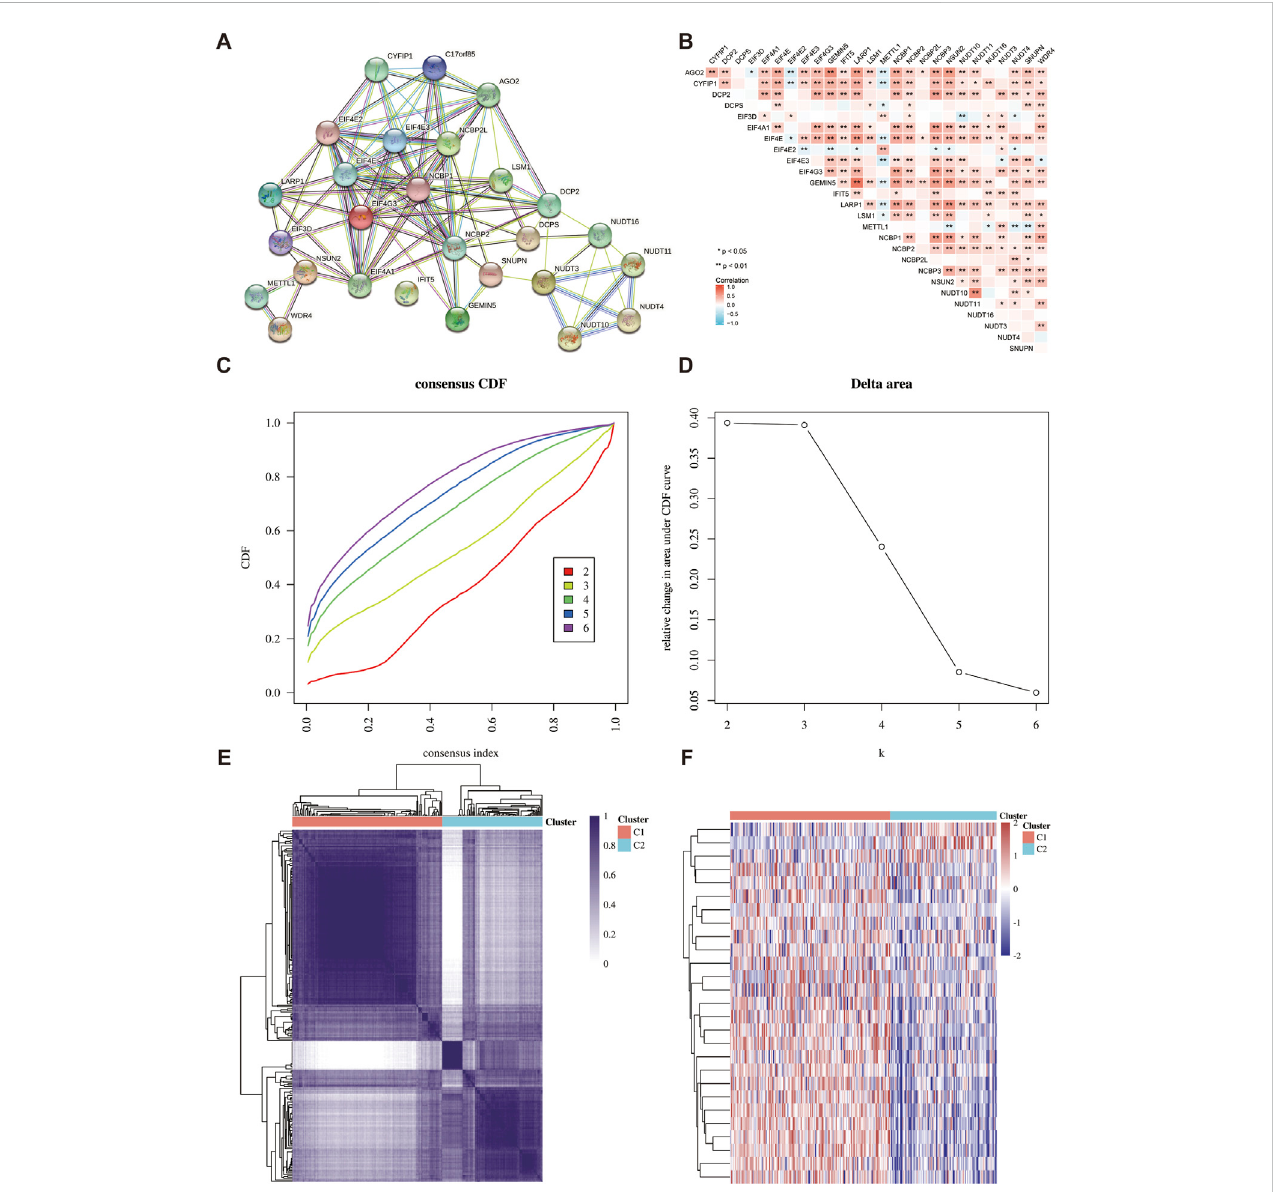
FIGURE 3 Identi fi cation of common clusters based on the expression of m7GRGs. (A) Protein-protein interaction of twenty-seven m7GRGs; (B) Pearson correlation analysisof twenty-seven m7GRGs expressions in sarcomas; (C) cumulative distribution function (CDF) (k =2 – 6); (D) relativechange ofarea under CDFcurve(k=2 – 6); (E) consensusclusteringmatrix(k=2). (F) Theheatmapofm7GRGexpressionindifferentsubgroups;redforhighexpressionandbluefor low